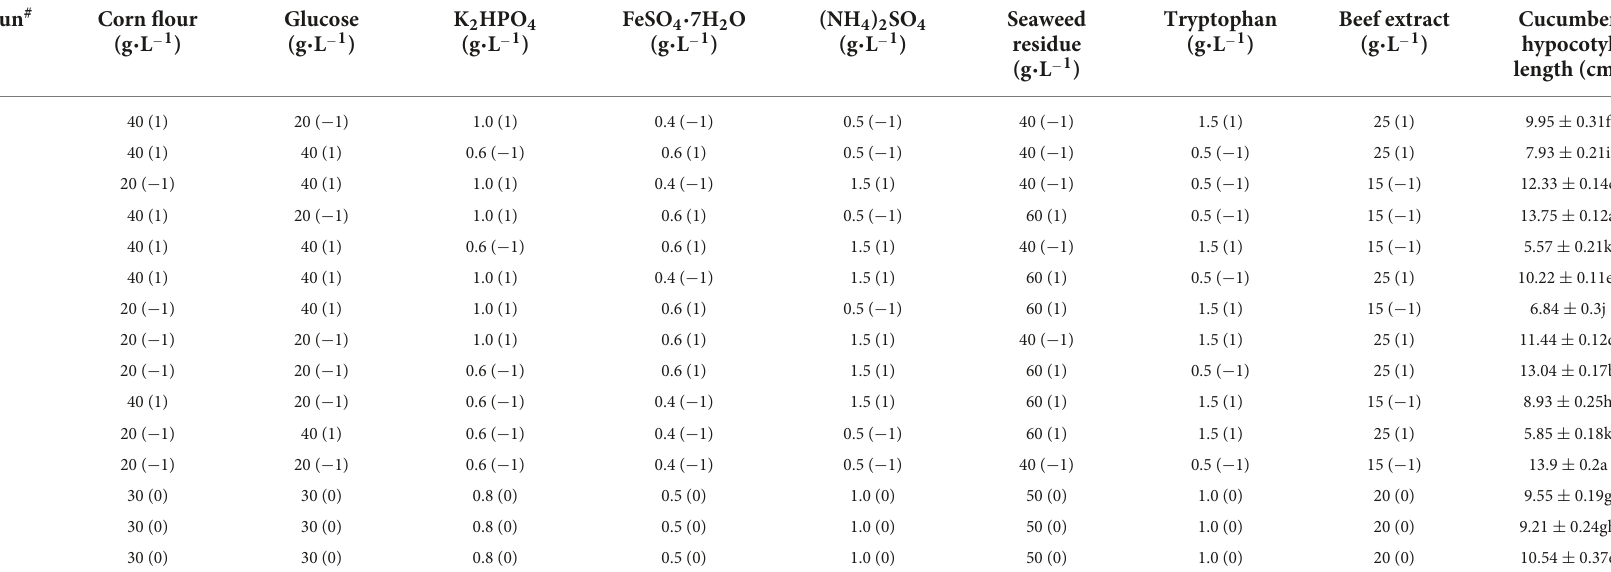
TABLE 1 Cucumber hypocotyl length for 15 runs with 8 factors in Plackett–Burman